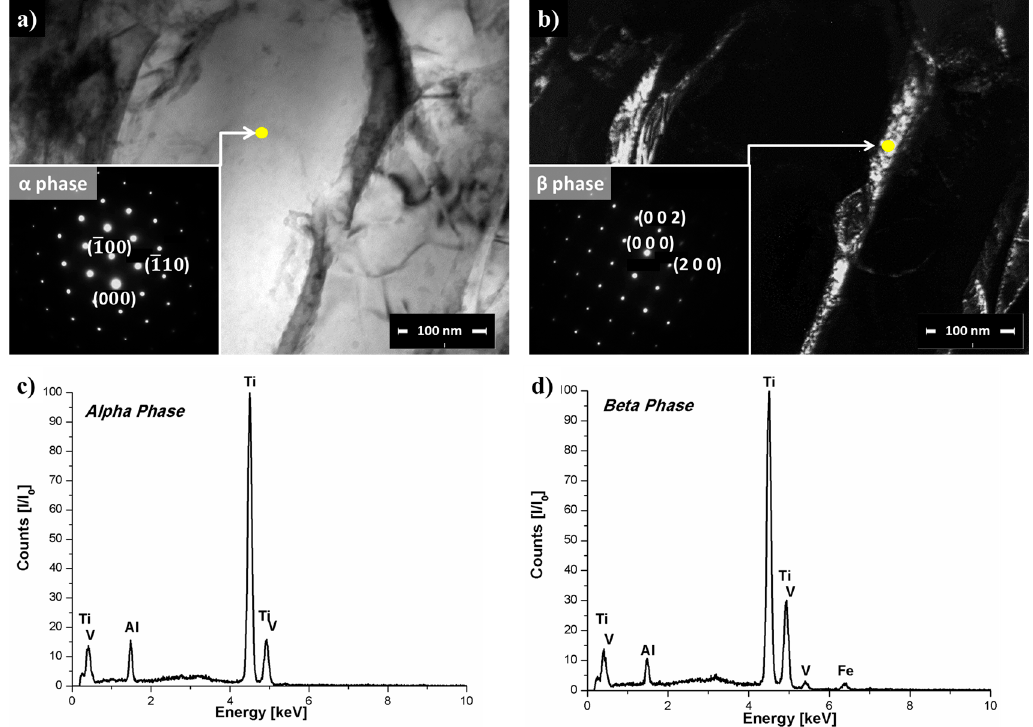
Figure 14. ( a ) TEM BF image of Region 2 from Figure 11b with the respective SAED pattern oriented in the [0001] α -Ti zone axis; ( b ) TEM DF image of Region 2 from Figure 11b detailing the β -Ti phase with SAED oriented in the [001] β -Ti zone axis. EDS spectra showing the chemical composition of the ( c ) α -Ti phase and ( d ) β -Ti phase in Region 2.